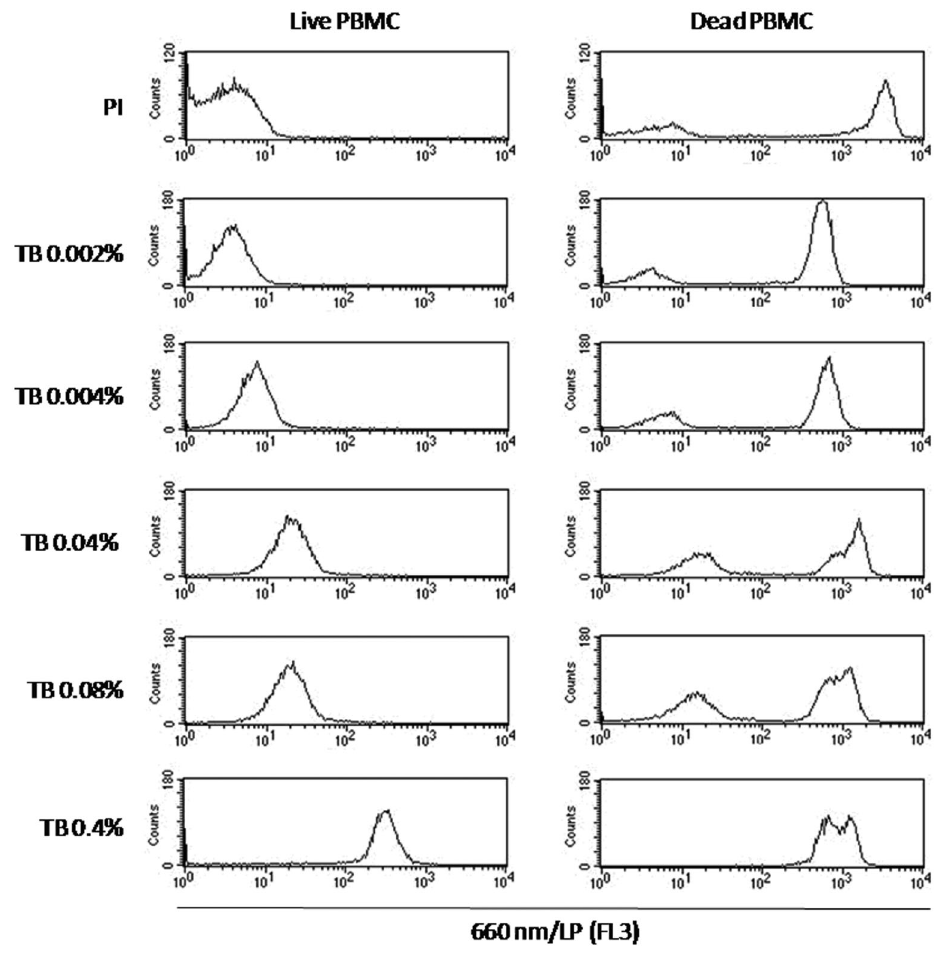
Figure 3. Evaluation of the optimum concentration for trypan blue (TB) solution ranging from 0.002 to 0.4% to discriminate between live and dead peripheral blood mononuclear cells (PBMC). The analysis was performed on a FACScan cytometer (Becton & Dickinson, USA) using the long-pass filter 650/LP (FL3 detector). Staining with propidium iodide (PI) was used as a reference.